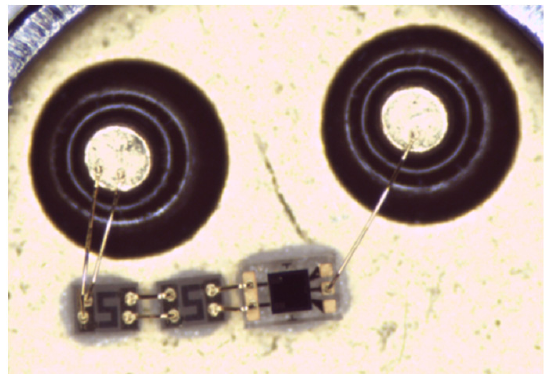
Figure 2. Image of the 10 Gbps planar InGaAs/InP APD TO package.